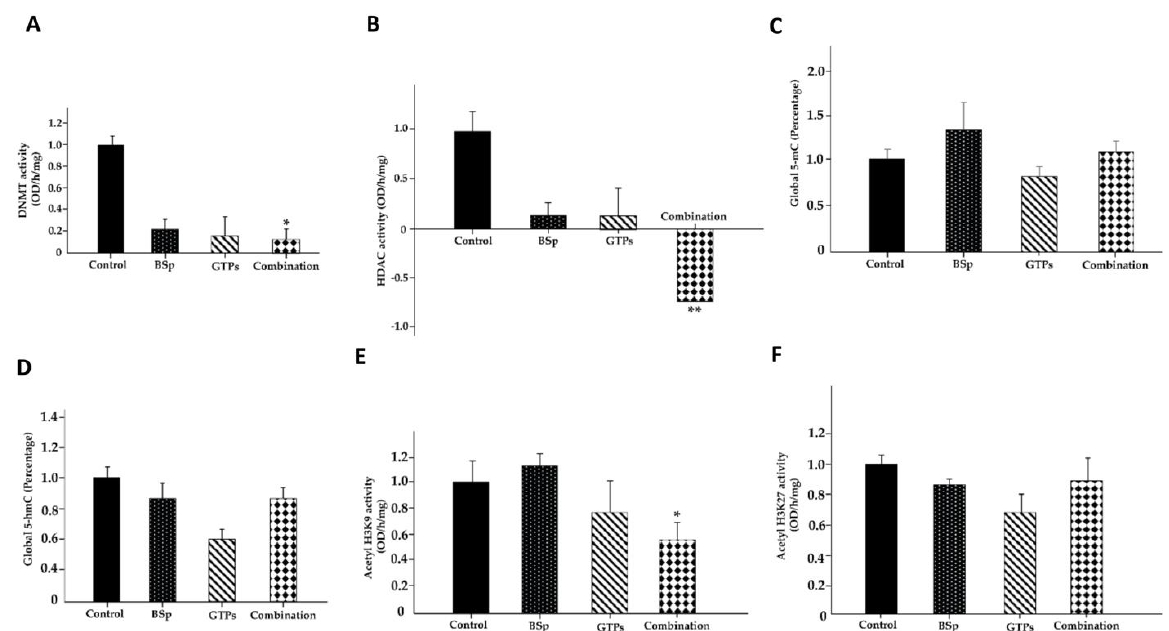
Figure 9. Global epigenetic profiles in response to BSp, GTPs and combination treatment groups. ( A ) DNMT activity. ( B ) HDAC activity. ( C ) 5-mC level. ( D ) 5-hmC level. ( E ) Acetyl-H3K9 activity. ( F ) Acetyl-H3K27 activity across different treatment groups. Columns, mean; bars, SE; * p < 0.05, ** p < 0.001, significantly different from the control group.